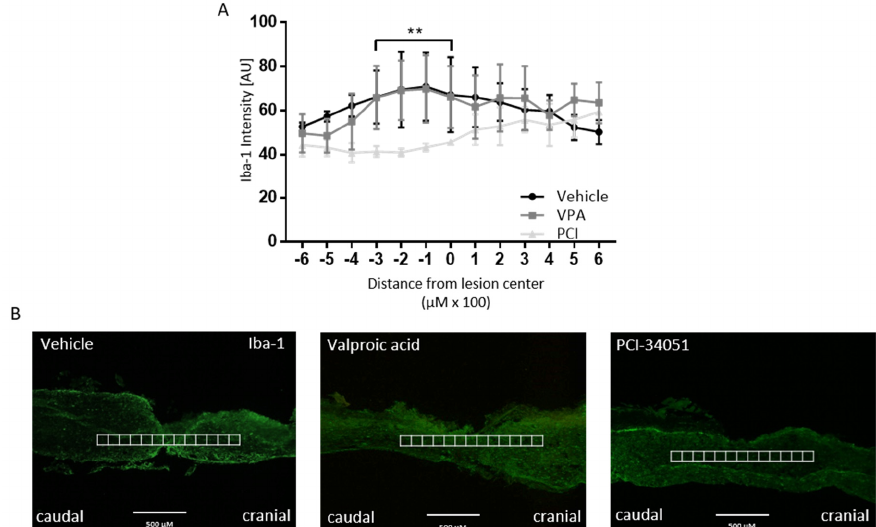
Figure 5. PCI-34051 reduces Iba-1 + cell infiltration after SCI. ( A ) PCI-34051 reduces Iba-1 + cell infiltration. VPA has no effect on Iba-1 + cell infiltration. ( B ) Representative images display the method of quantification: Iba-1 expression was quantified by intensity analysis within rectangular areas of 100 µm × 100 µm, extending 600 µm cranial to 600 µm caudal from the lesion epicenter. Data are represented as means ± SEM, n = 3–4 mice/group. ** p < 0.01. SCI: spinal cord injury; Iba-1: ionized calcium-binding adapter molecule 1; VPA: valproic acid; PCI: